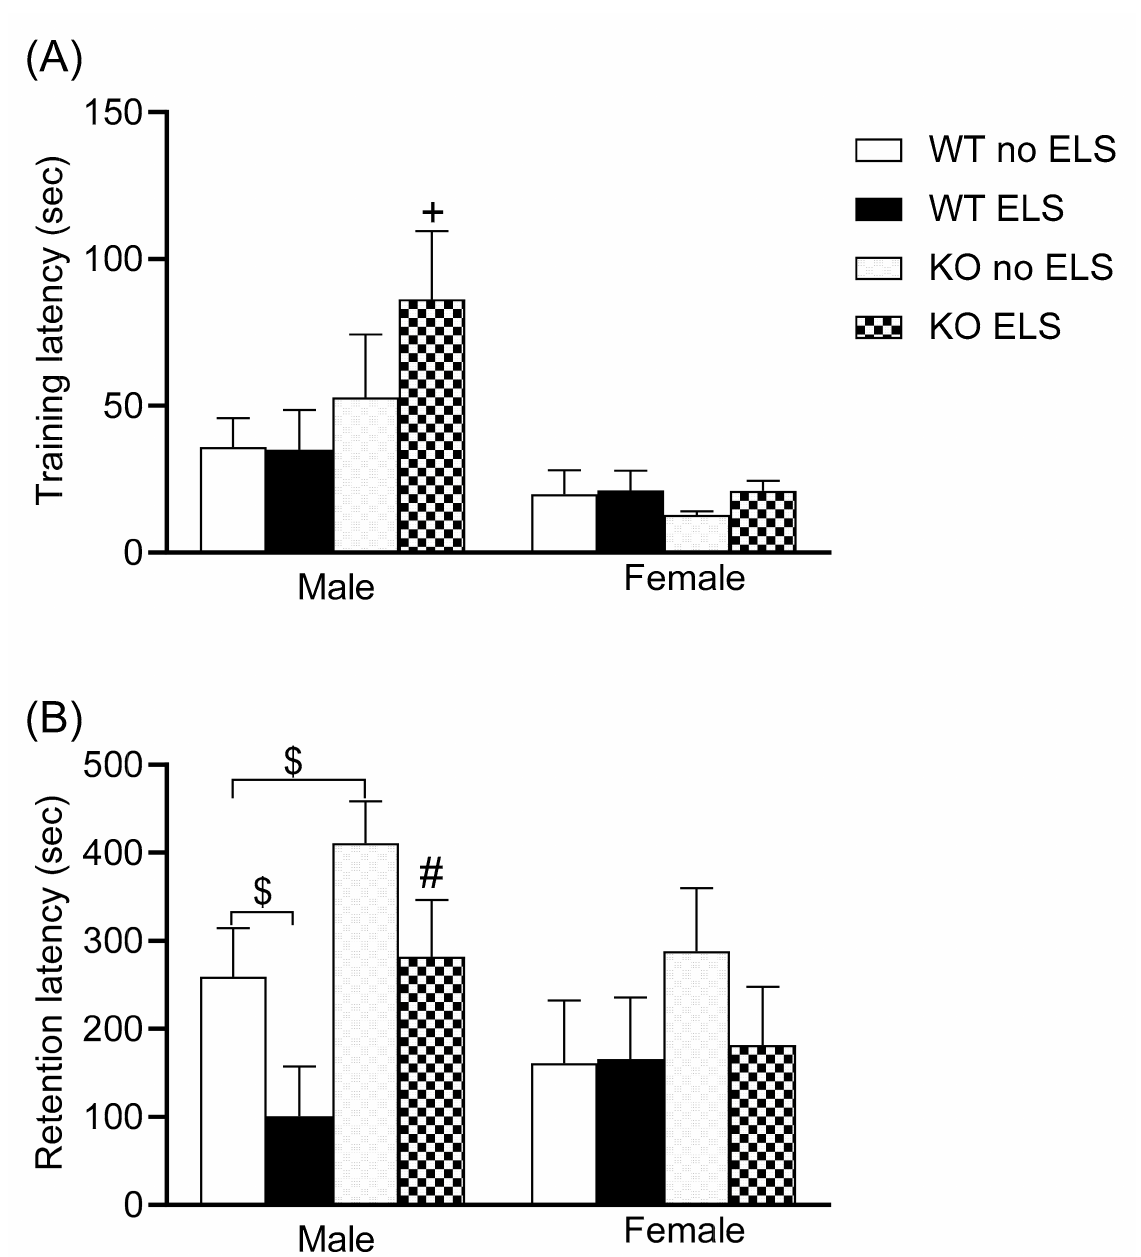
Figure 4. Effect of ELS on WT and GPR37KO mice in passive avoidance task. Training latency ( A ). Retention latency ( B ). N/group: WT no-ELS male = 9, WT ELS male = 7, KO no-ELS male = 9, KO ELS male = 10, WT no-ELS female = 8, WT ELS female = 7, KO no-ELS female = 9 and KO ELS female = 9. Results are expressed as mean ± SEM. All data represent mean ± SEM. # p < 0.05 versus corresponding WT; + p < 0.05 with respect to sex; $ p > 0.05 < 0.1 calculated by three-way ANOVA followed by multiple comparisons using the two-stage linear step-up procedure of Benjamini, Krieger and Yekutieli. WT = Wild Type, KO = Knockout, ELS = Early Life